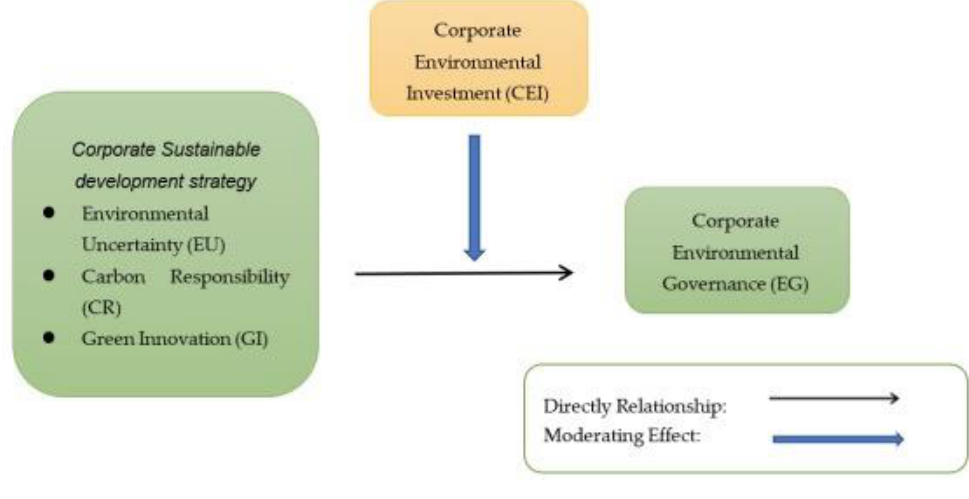
Figure 1. Research